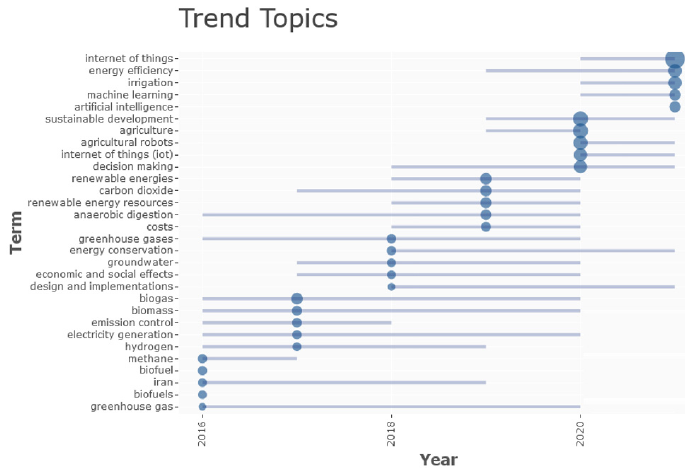
Figure 9. Trend topics of authors’ keywords. Source: Scopus - Biblioshiny.